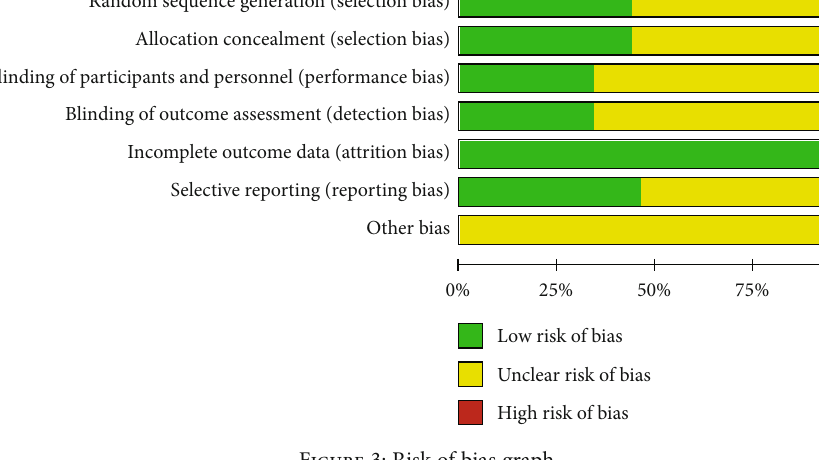
Figure 3: Risk of bias